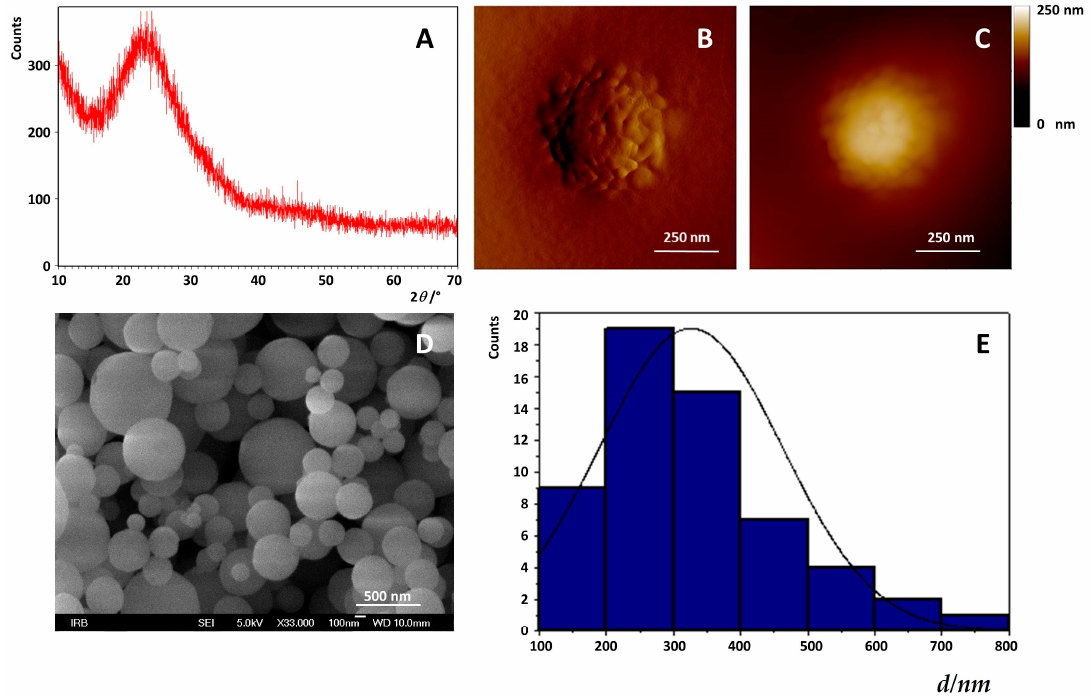
Figure 2. ( A ) The diffraction pattern of the investigated powdered MSNs, ( B ) amplitude and ( C ) 2D height image of MSNs. ( D ) Field emission scanning electron microscope (FE-SEM) micrograph of MSNs as used. ( E ) The histogram of the size distribution of MSN. Table 1. The porosity, morphology and stability of MSNs in powder and dispersed in wate r. Powder MSN